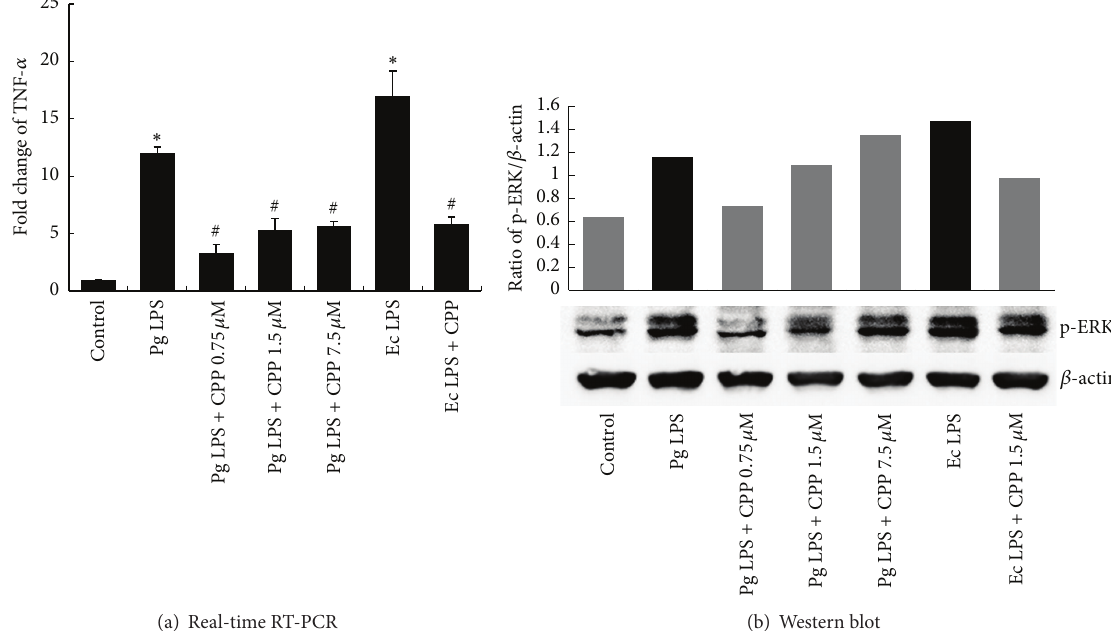
Figure 3: Effects of GV1001 on LPS-induced TNF- 𝛼 and p-ERK production in hDPCs. 0.75, 1.5, and 7.5 𝜇 M GV1001 were added to hDPSCs treated with 1 𝜇 g mL −1 of E. coli LPS or 20 𝜇 g mL −1 of P. gingivalis LPS for 10hrs. RT-PCR and Western blot revealed downregulation of (a) TNF- 𝛼 and (b) phosphorylated ERK, respectively, after exposure of cells incubated with GV1001 and 1 𝜇 gmL −1 of E. coli LPS or 20 𝜇 g mL −1 of P. gingivalis LPS. Each value indicates the mean ± SEM of three independent experiments. # indicates a significant difference ( 𝑃 < 0.05 ) relative to cells treated with LPS in the presence of